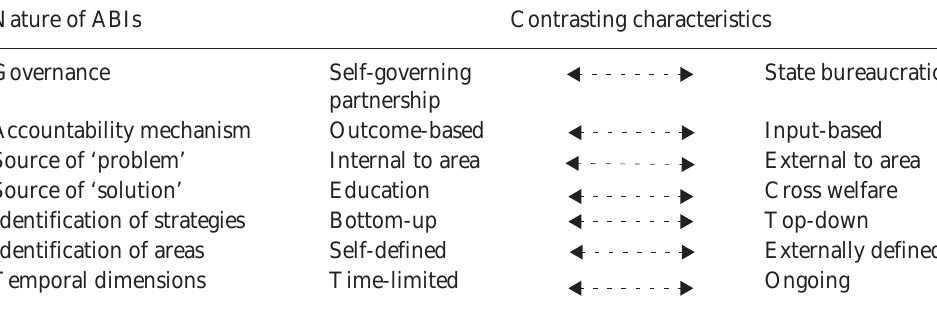
Table 1 Schema for identifying the key characteristics of ABIs Nature of